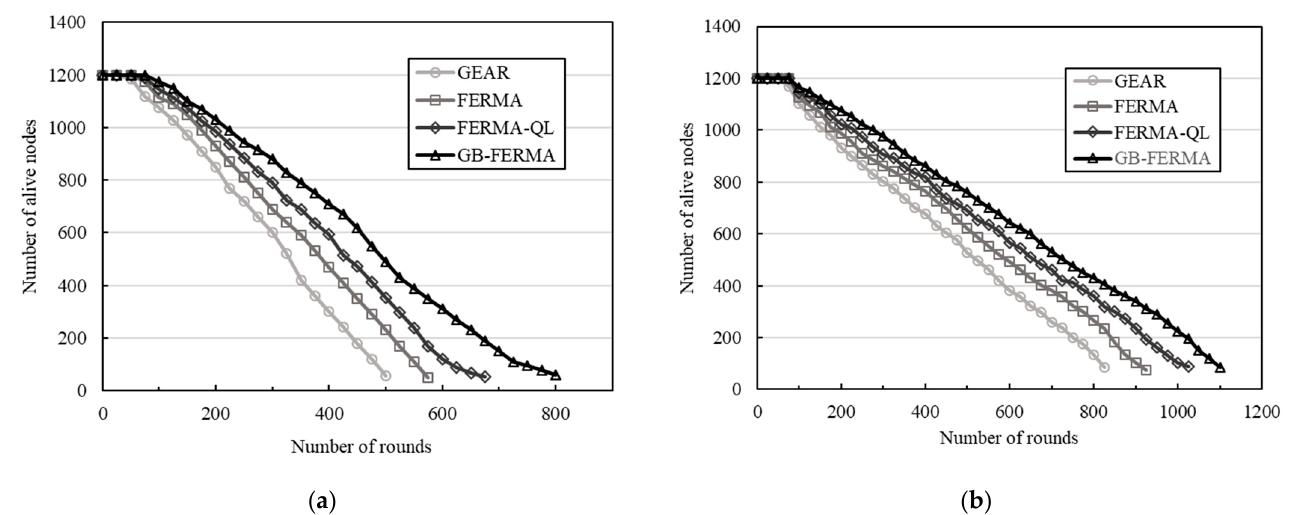
Figure 10. Number of alive nodes versus number of rounds: ( a ) initial power 0.25 J; ( b ) initial power 0.5 J.